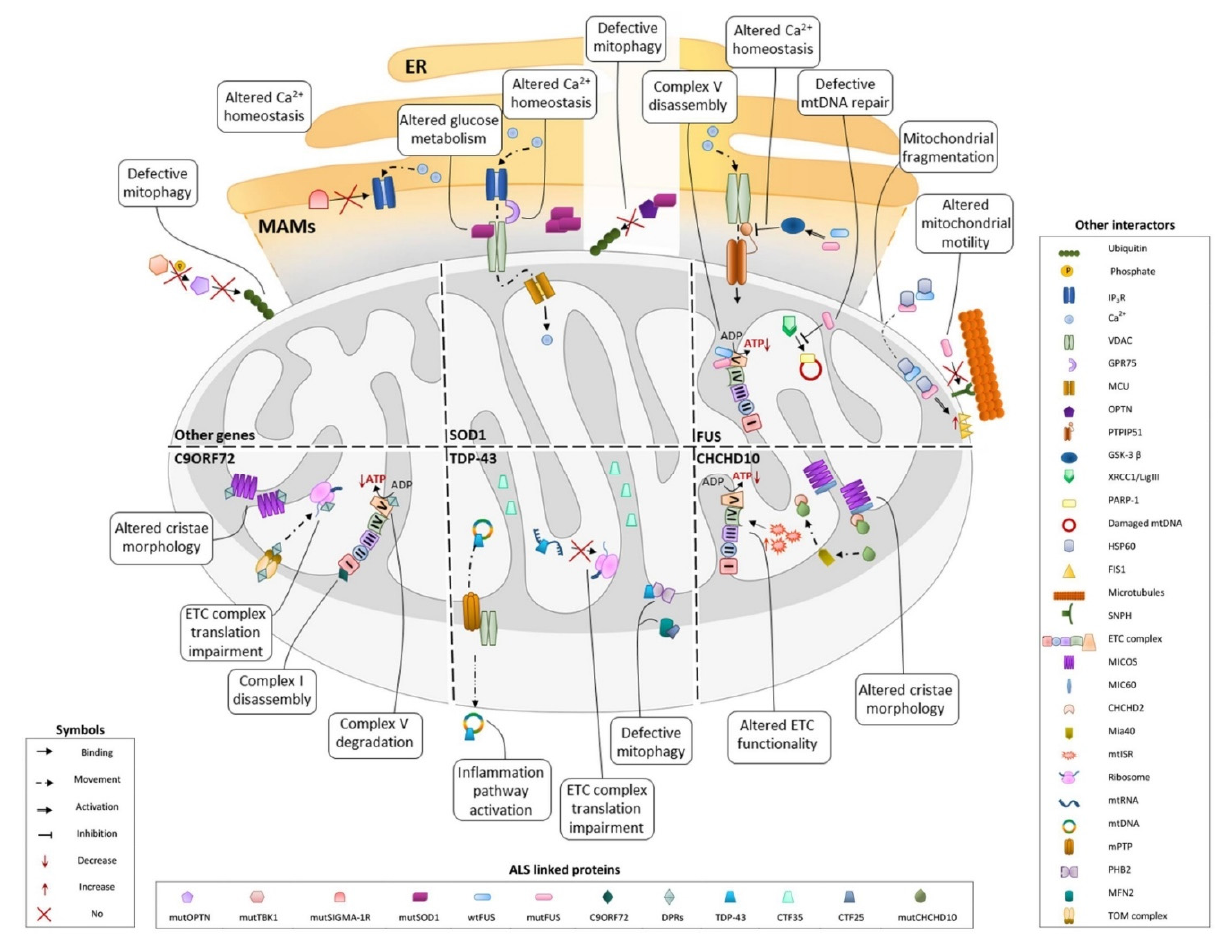
Figure 1. Latest mechanistic findings on principal ALS-related proteins in mitochondrial dysfunctions. Schematic representation showing a five years update of the mechanistic contribution of main ALS-related proteins in mitochondrial deficits.